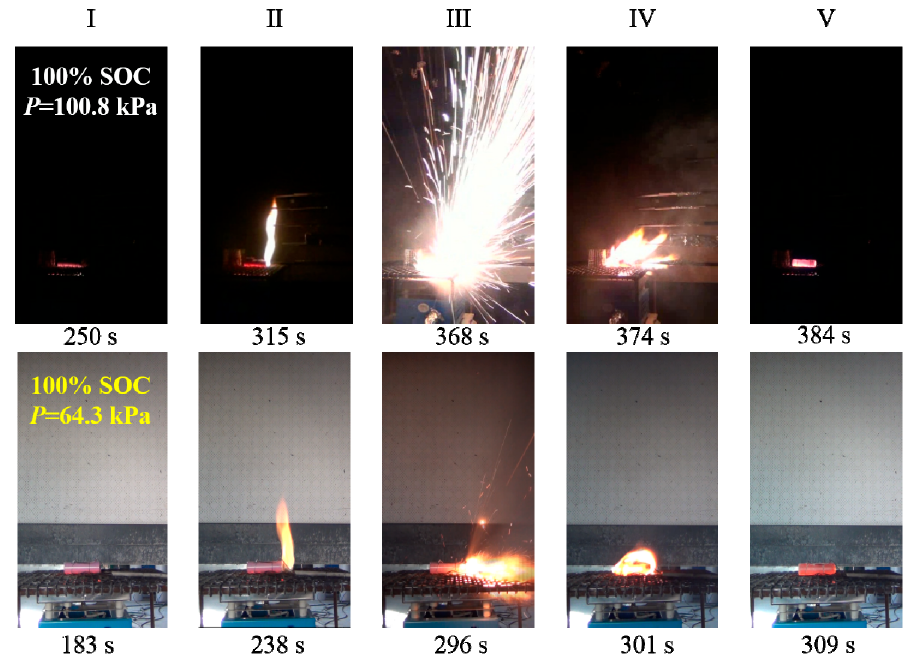
Figure 8. The burning process of 100% SOC (state of charge) 18,650 batteries at two pressures.